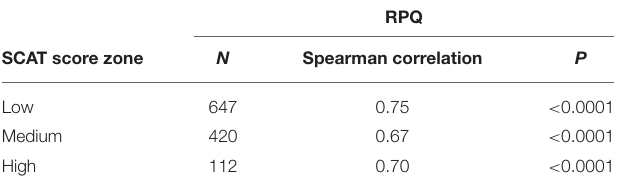
TABLE 4 | Spearman correlations between Rivermead Post-concussion Symptoms Questionnaire (RPQ) and low (0–25), medium (26–75), and high (75–132) score zones on the Sports Concussion Assessment Tool